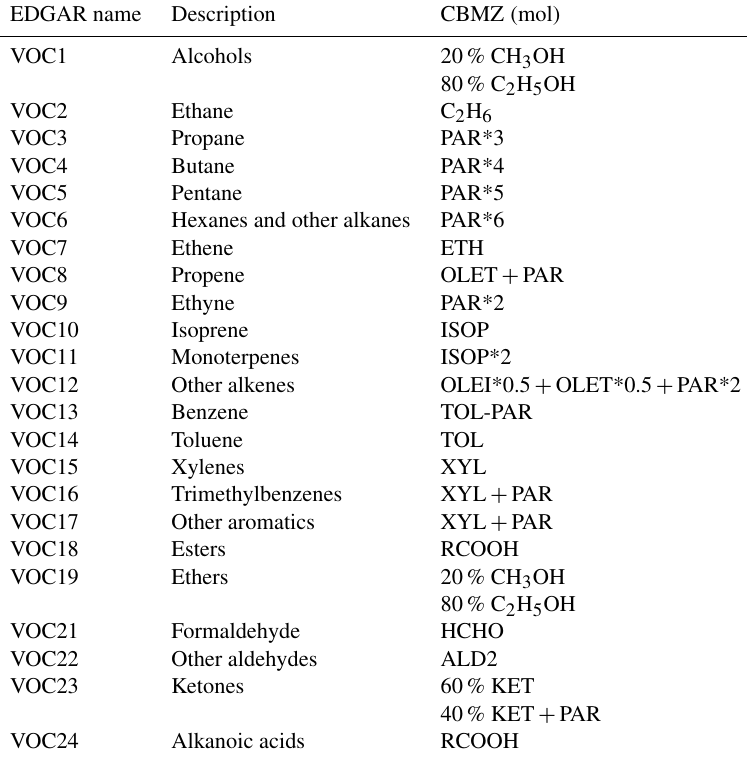
Table 2. Map of NMVOC from EDGAR emission to CBMZ scheme.